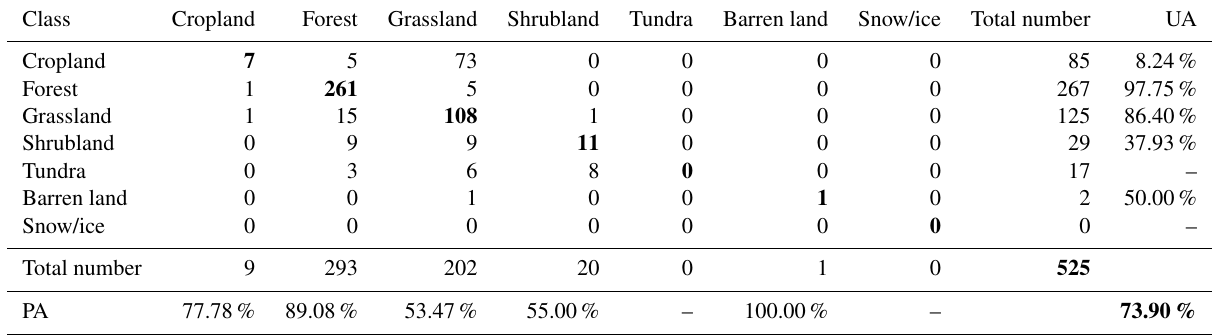
Table 7. Classification accuracy of the MLCT (MODIS Land Cover Type) product in 2015 based on FLUXNET test samples (overall accuracy = 82.10%; UA denotes user’s accuracy, and PA denotes producer’s accuracy). Bold numbers represent correctly classified ones.